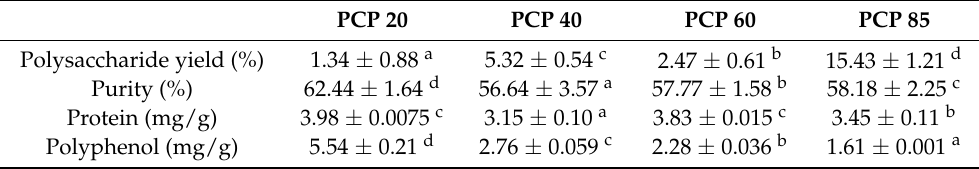
Table 1. The chemical compositions of Polygonatum cyrtonema Hua polysaccharides. PCP 20 Polysaccharide yield